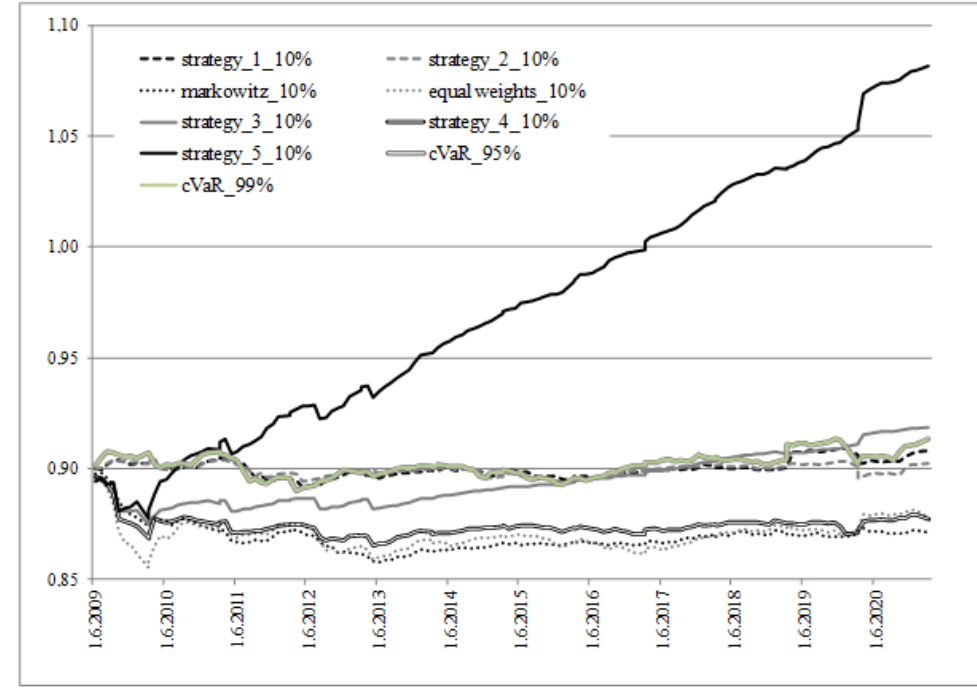
Figure 3. Portfolio values over time.